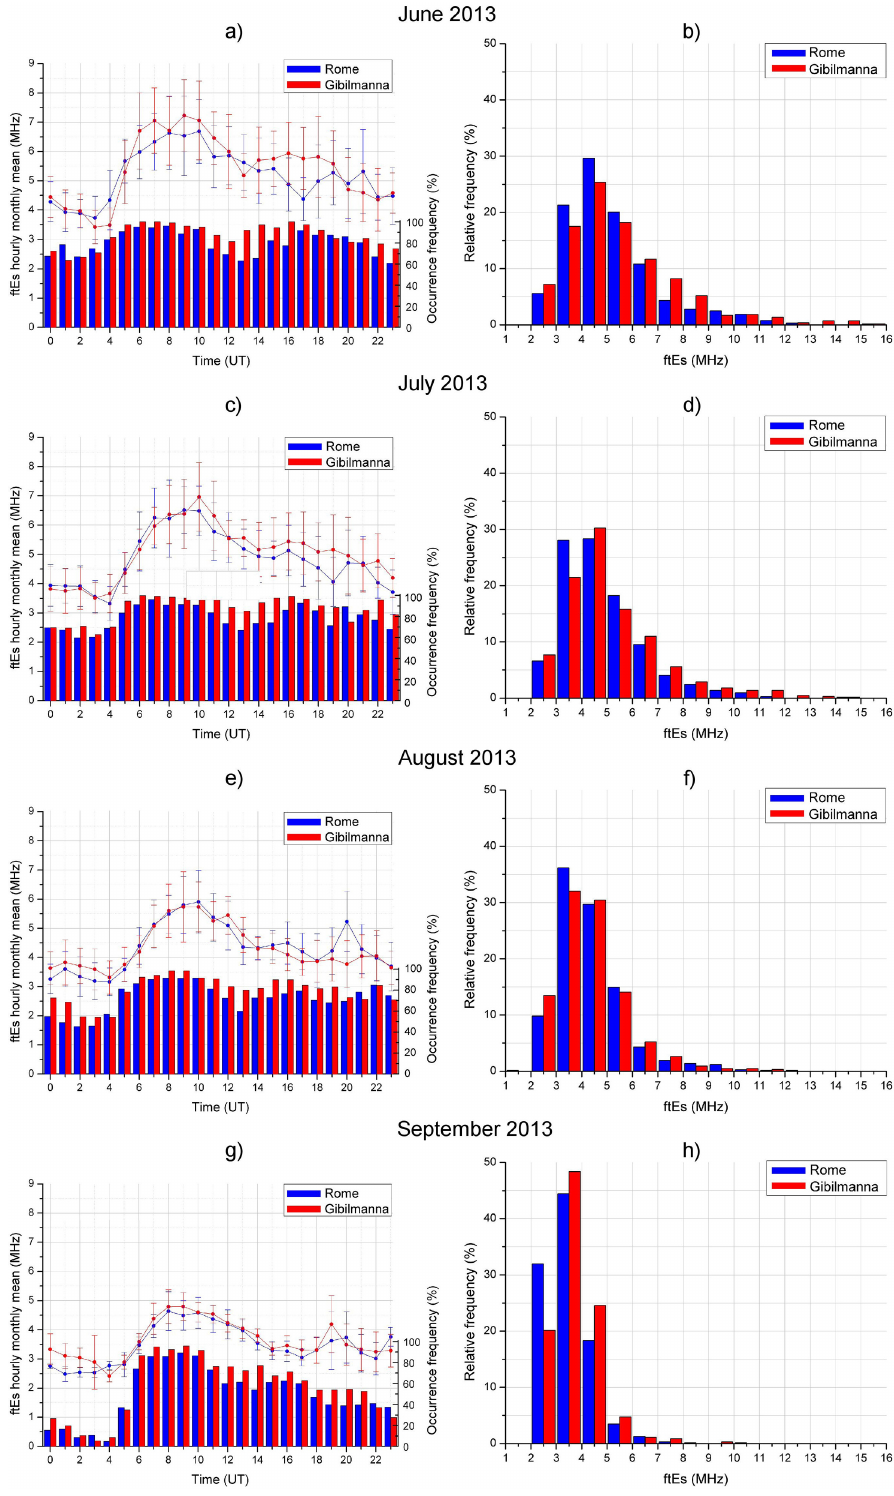
Figure 4. ftEs hourly monthly mean values with the corresponding standard deviation along with the occurrence frequency of the Es layer for (a) June, (c) July, (e) August and (g) September 2013, and the relative frequency of the ftEs hourly mean values for (b) June, (d) July, (f) August and (h) September 2013, for Rome (in blue) and Gibilmanna (in